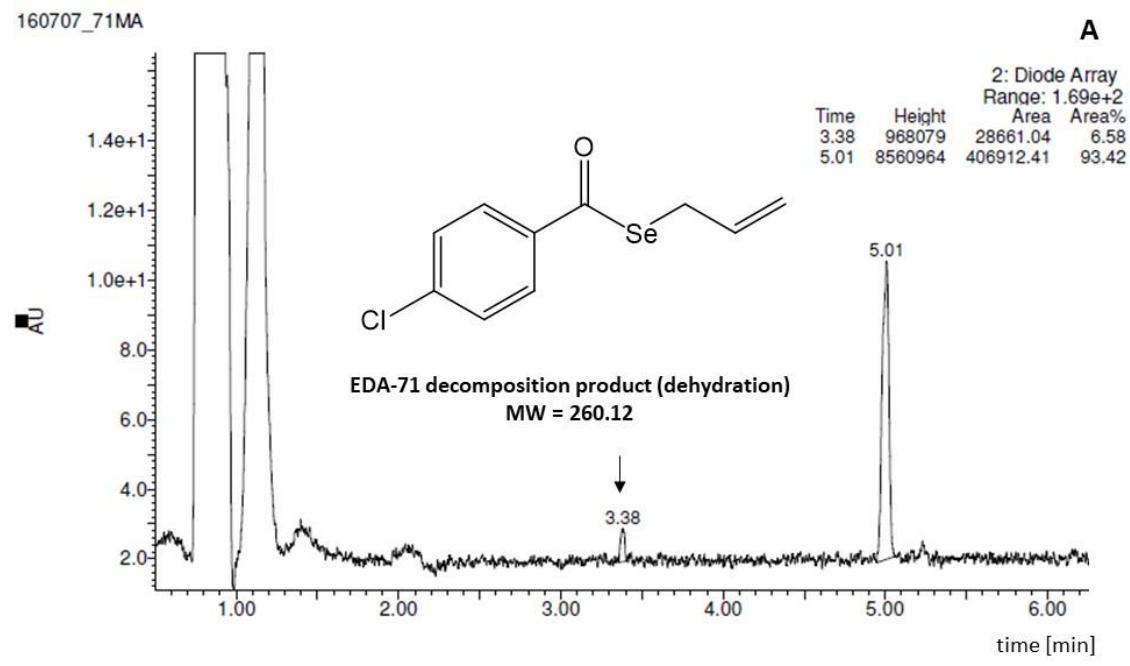
Figure 5. Stability of EDA-71 during its analysis in organic solvents. The assay confirmed the pres- ence of only one peak, which corresponded to the weight of EDA-71 ( m / z = 276.60). Diode Array, range: 1.327× 10 2